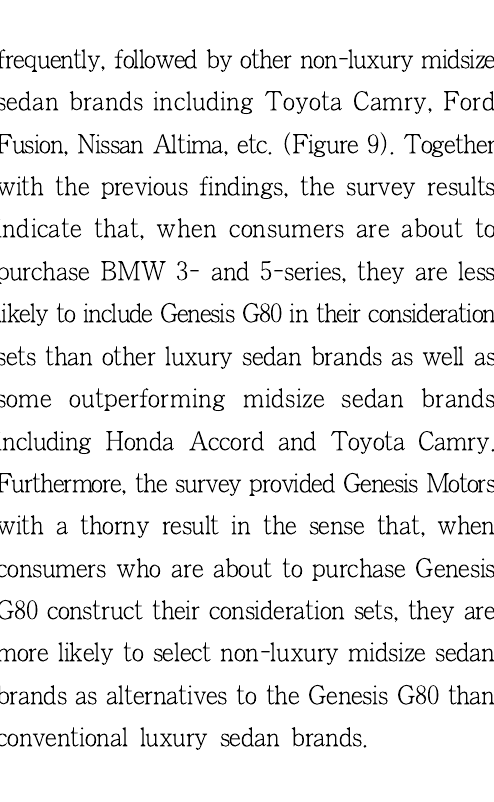
Data created by authors through a